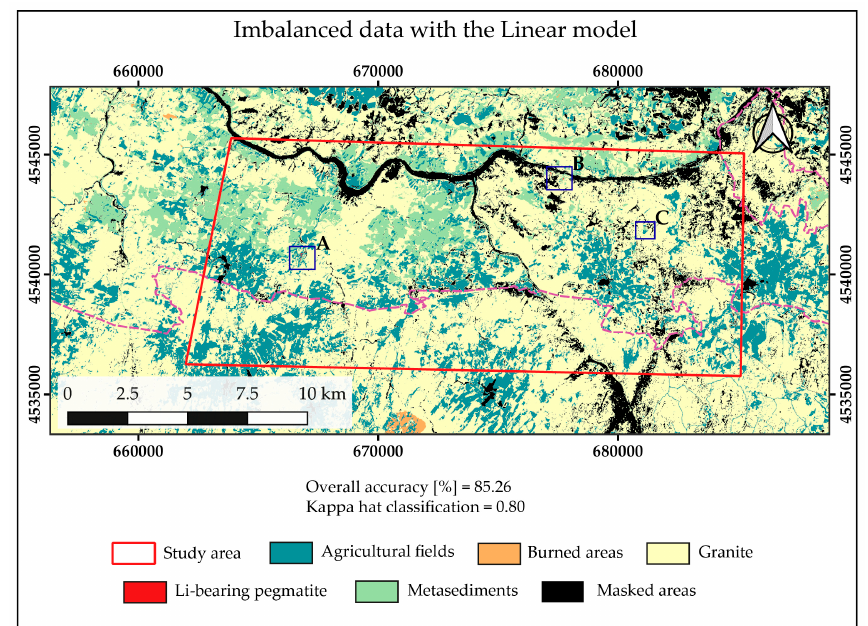
Figure 7. Final classification map based on the Linear-SVM model built with imbalanced data. Three open-pit mines exploiting Li-minerals are identified: A—Bajoca, B—Feli, and C—Alberto. The dashed purple line represents the simplified contact between the Metasediments and the Granite. Zoom images of the open-pit mines can be found in Figure 9.